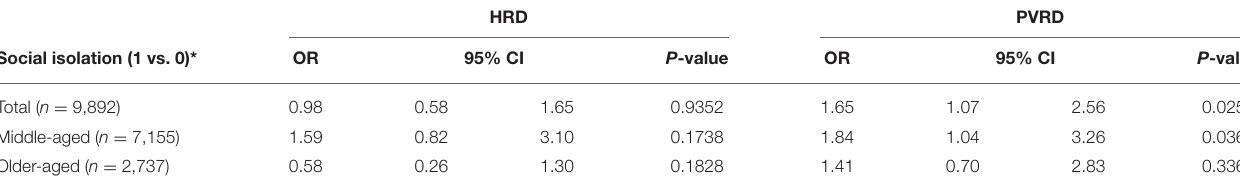
TABLE 4 | Main effects associations between social isolation and